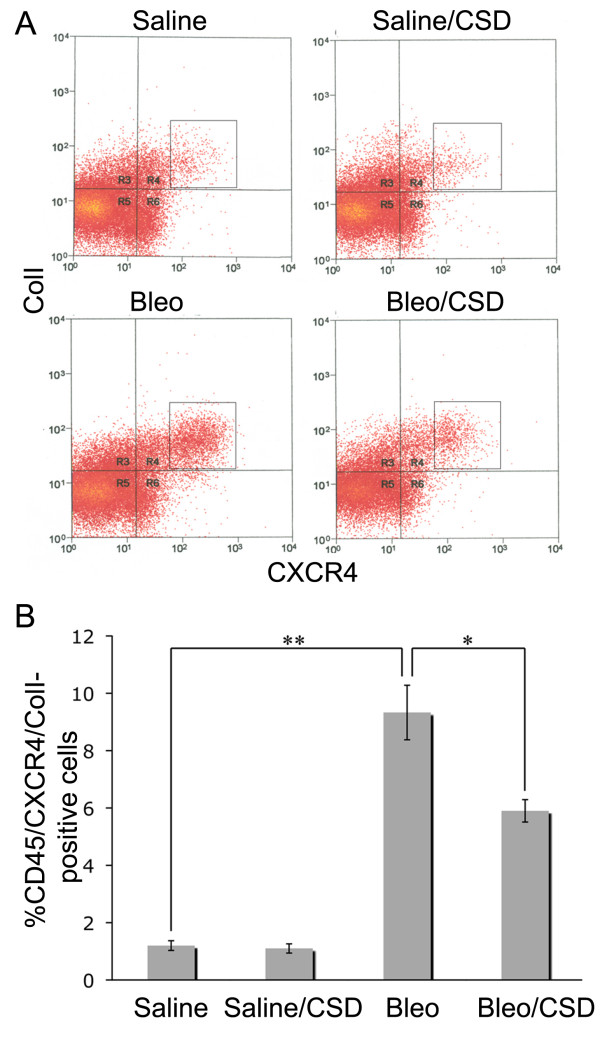
Flow cytometric quantification of CD45+/CXCR4+/ColI+ fibrocytes in mouse lung tissue. Total lung cells were isolated from mice (three to six mice in each category) ten days after saline or bleomycin treatment. The mice had been treated daily with CSD or control peptide starting one day prior to saline or bleomycin treatment. CD45+/CXCR4high/ColI+ fibrocytes were quantified by performing flow cytometry. (A) Results from a typical experiment in which lung cells from the indicated individual mice were gated based on CD45 staining, then resolved on two-dimensional scatterplots based on their ColI and CXCR4 staining. Vertical and horizontal bars delimit the zone in which cells stained with isotype controls are found. We refer to the cells that are slightly into the upper right quadrant as CXCR4low, and we refer to cells within the box as CXCR4high. Therefore, the square box contains cells that are CD45+/CXCR4high/ColI+. (B) The percentage of cells falling within the square box is presented for each category of mice. The data represent the average of from three to six mice in each category ± standard error of the mean. **P < 0.01. *P < 0.05.